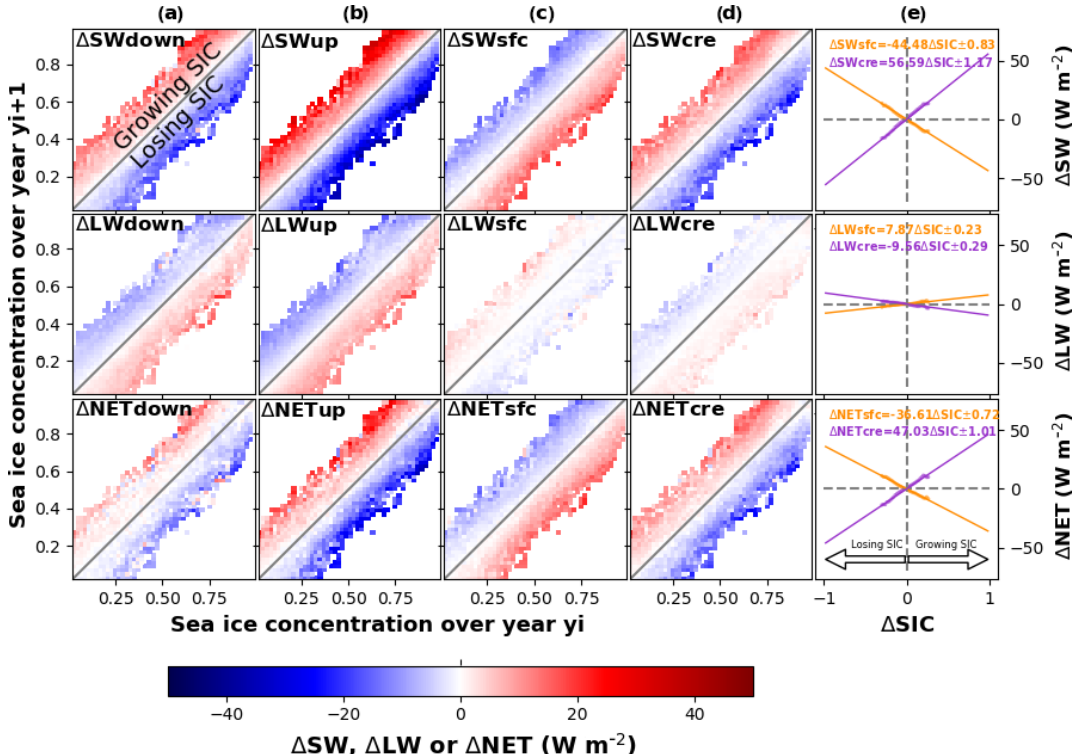
Figure 5. Annual changes in SW, LW and NET as a function of SIC. Annual changes in SW (top), LW (middle) and NET (bottom) of radiative down (a) , up (b) , sfc = down-up (c) and cre (d) over the Antarctic Ocean as a function of SIC change between 2 consecutive years, y i + 1 and y i , from the 2001 to 2016 time period. The top triangles in ( c top) refer to the increase (growing) in SIC, while the blue colours mean a reduction (cooling) in SW sfc . The top triangles in (d) refer to the increase in SIC, while the red colours mean an increase (decreasing the cooling role of clouds) in SW cre . Each dot in column (e) represents the average of one parallel to the diagonal in (c) or (d) as described in Sect.